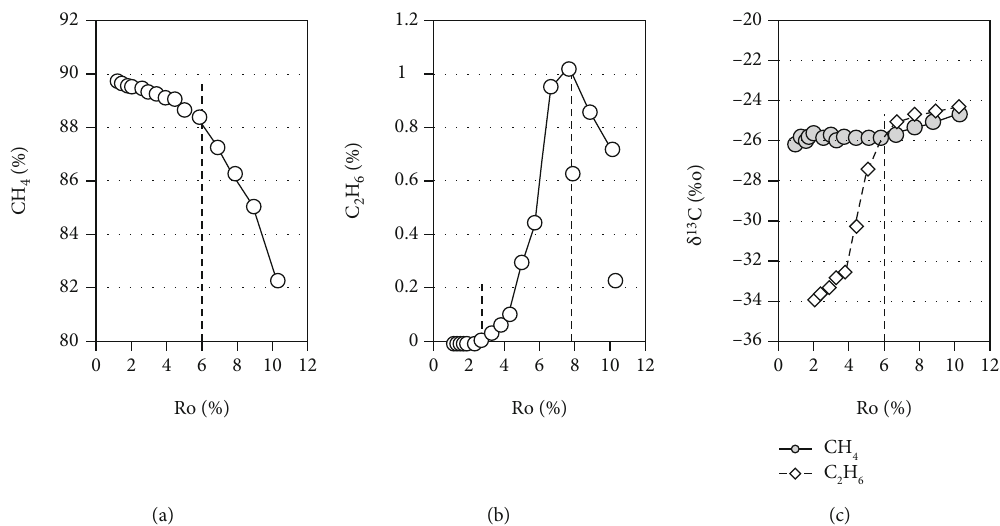
Figure 6: Variations in main alkane gas content and δ 13 C increasing calculated %R o . (b) Variation in C increasing calculated %R o